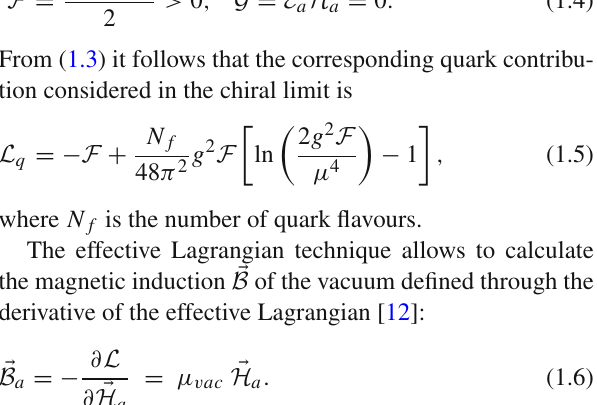
In case of the Heisenberg–Euler effective Lagrangian